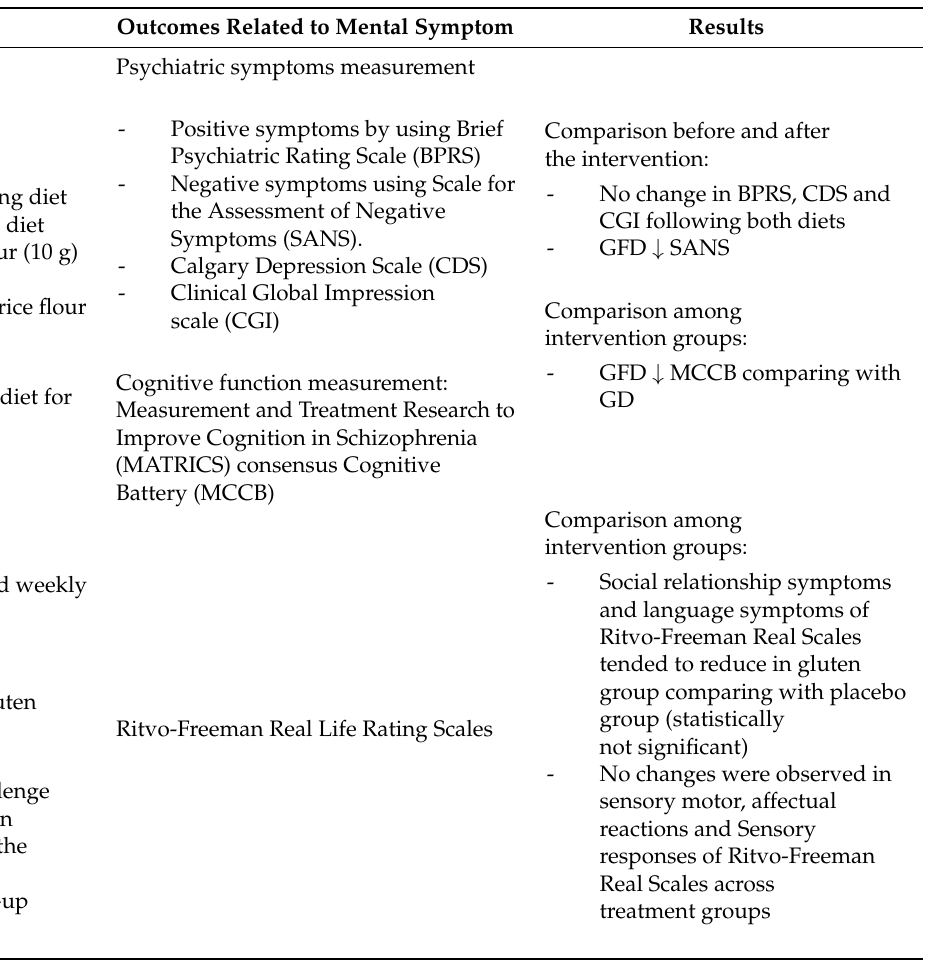
Table 2. Characteristics and results of clinical and randomized controlled trials related with schizophrenia and autism spectrum mental